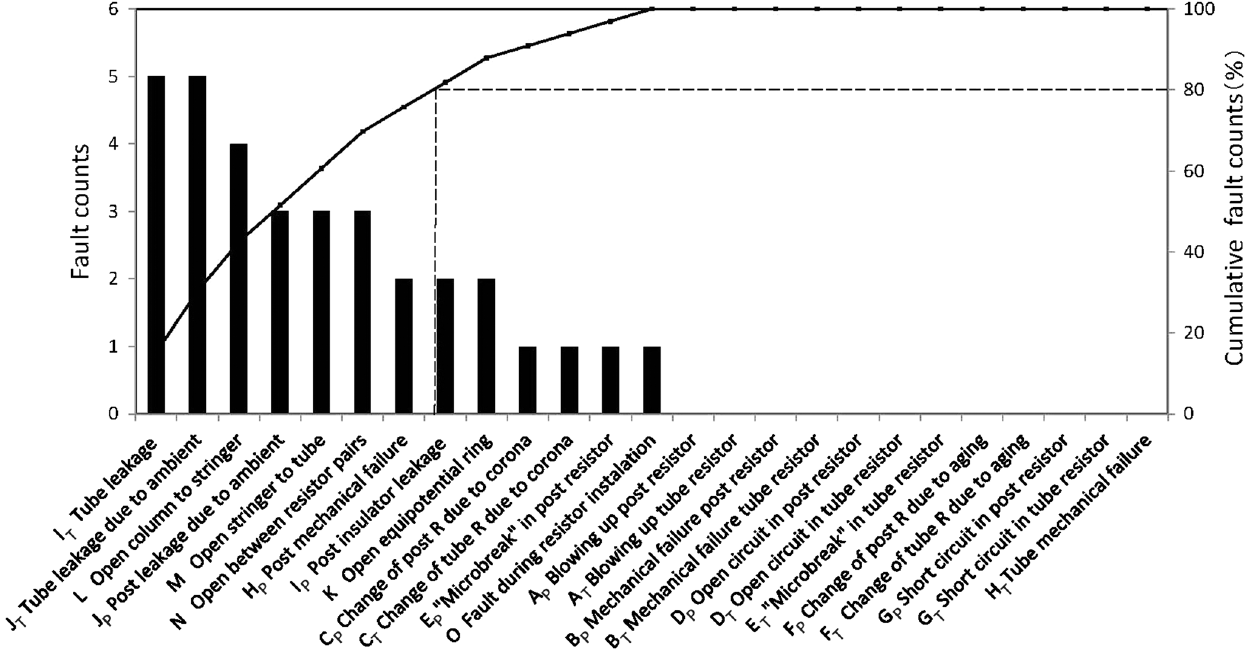
FIG. 11. Pareto chart of the number of 14UD electrostatic structure fault occurrence as discovered during the maintenance five tank openings spanning from TO #119 to TO #123. The dashed line starting at 80% of the right y axis highlights 80 – 20 rule. Subscript letters “ T ” and “ P ” are used to refer to accelerating tube or post